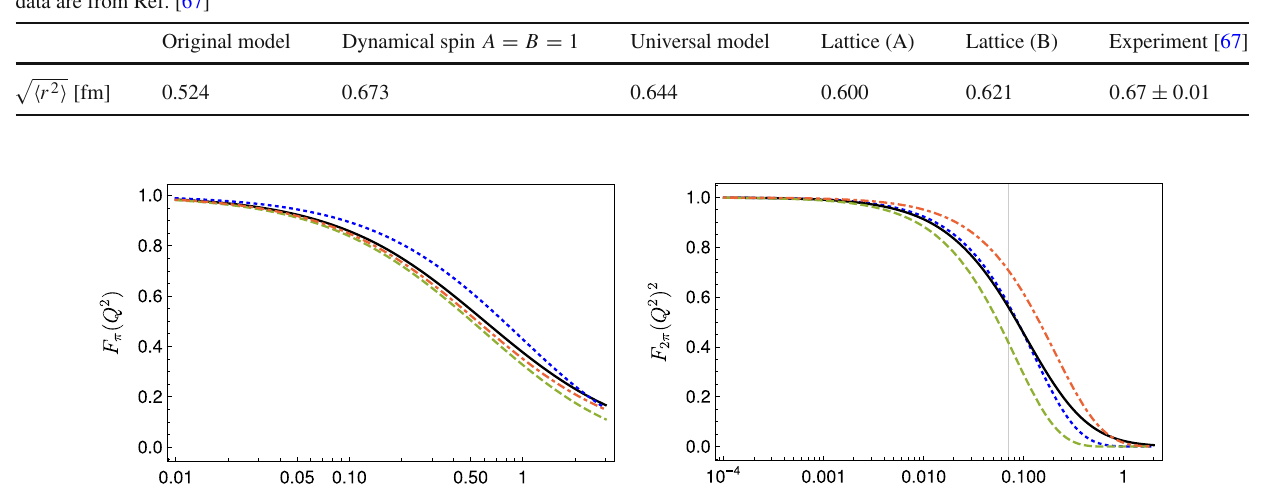
ration, and the universal model (dot-dashed red line). Right panel, same of the left panel for the square of the eff F 2 π ( Q 2 ) 2